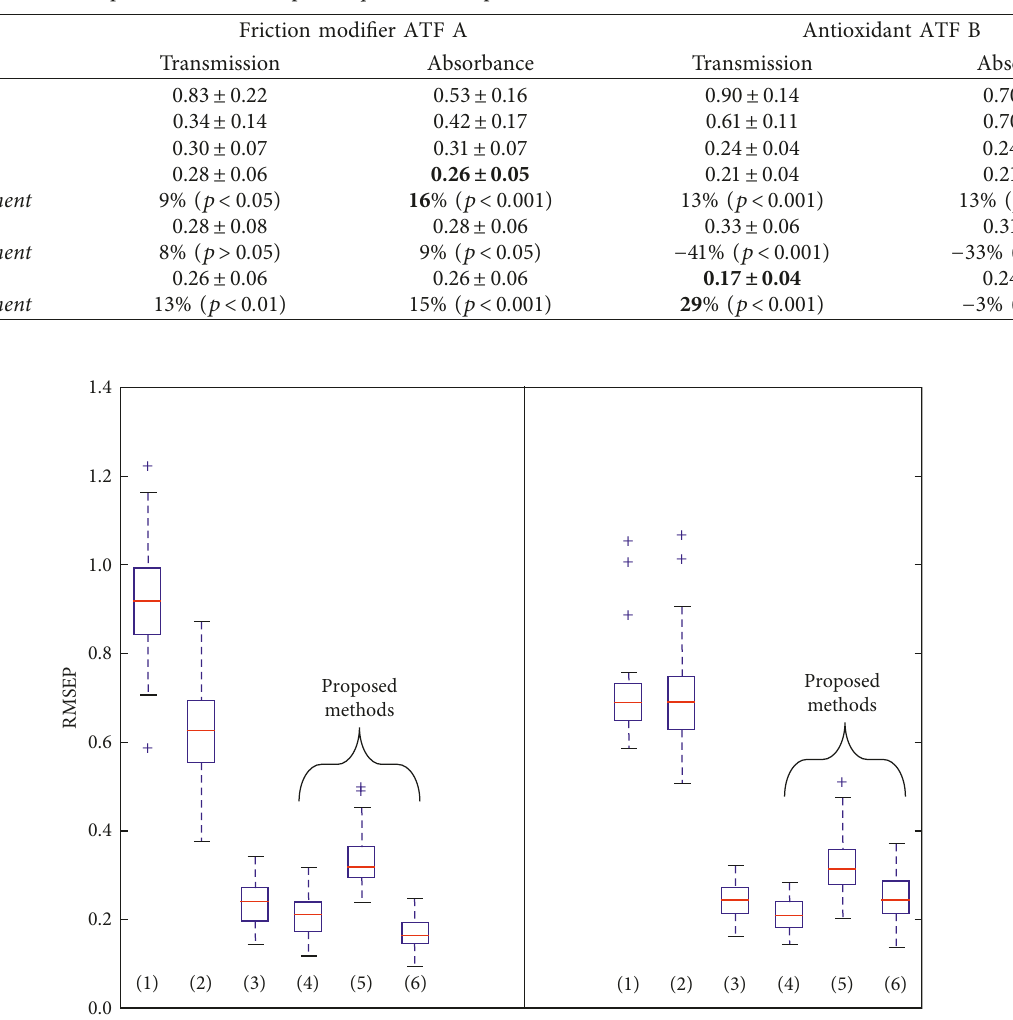
Table 2: Summary of the model performances described by the mean value and the standard deviation of the RMSEP values during cross validation. The relative improvements and respective p -values compared with LSNV are also